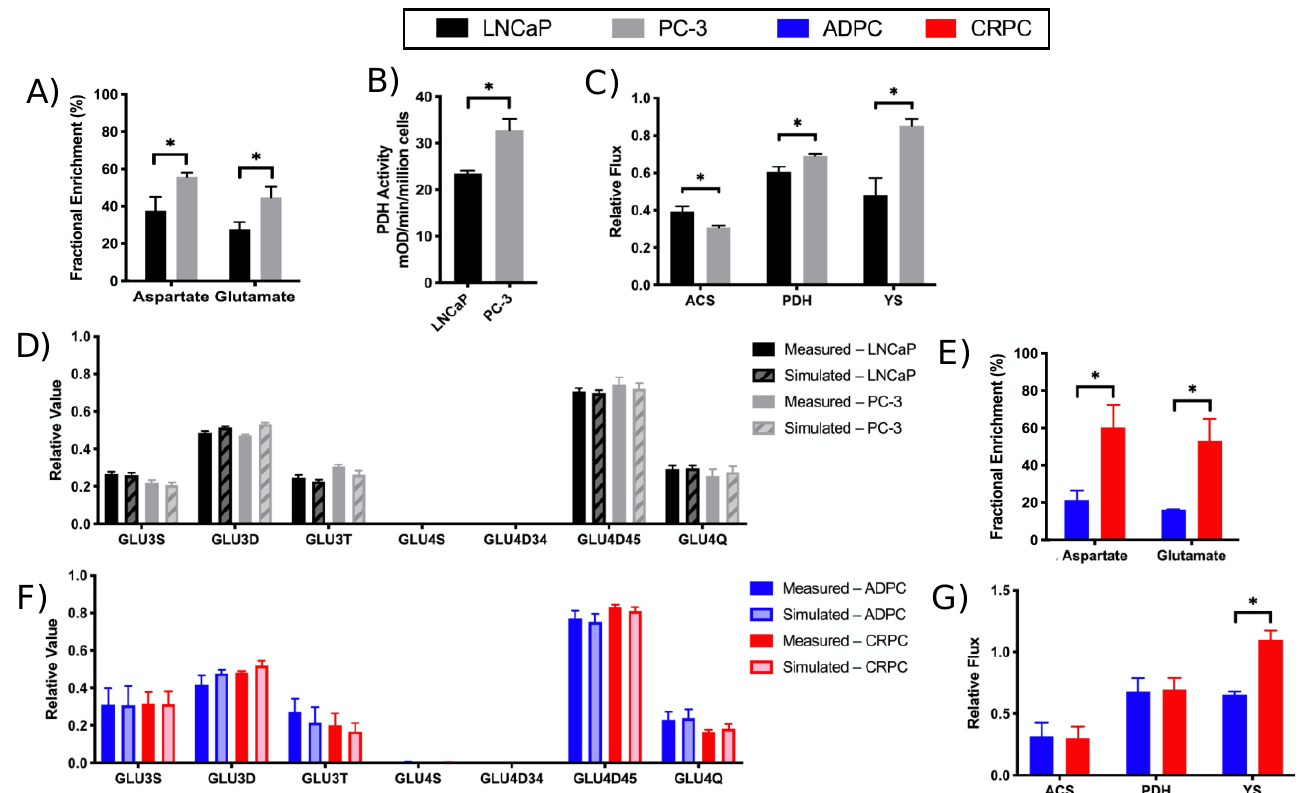
Figure 4. Pyruvate oxidation is increased in CRPC to fuel the TCA cycle. Flux of pyruvate through the TCA cycle was assessed in LNCaP and PC-3 cells by measuring ( A ) the fractional enrichment of aspartate and glutamate in cells labeled with [U- 13 C]glucose and ( B ) enzymatic activity of PDH. ( C ) Calculated values for the relative flux of unlabeled acetate and other fatty acids into the TCA cycle (ACS), relative 13 C-glucose flux into the TCA cycle (PDH), and the anaplerotic contribution relative to citrate synthase (YS) using TCACALC. ( D ) 13 C isotopomer modeling of [U- 13 C]glucose-labeled LNCaP and PC-3 cells using TCACALC showed measured and simulated relative 13 C isotopomer areas of the glutamate C3 and C4 multiplets. Flux of pyruvate through the TCA cycle was determined in ADPC and CRPC TRAMP tumors by measuring ( E ) fractional enrichment of aspartate and glutamate of tumors labeled with [U- 13 C]glucose. 13 C isotopomer modeling of [U- 13 C]glucose-labeled ADPC and CRPC TRAMP tumors using TCACALC showed ( F ) measured and simulated relative 13 C isotopomer areas of the glutamate C3 and C4 multiplets and ( G ) calculated values for the relative flux of ACS, PDH, and YS. (* p <